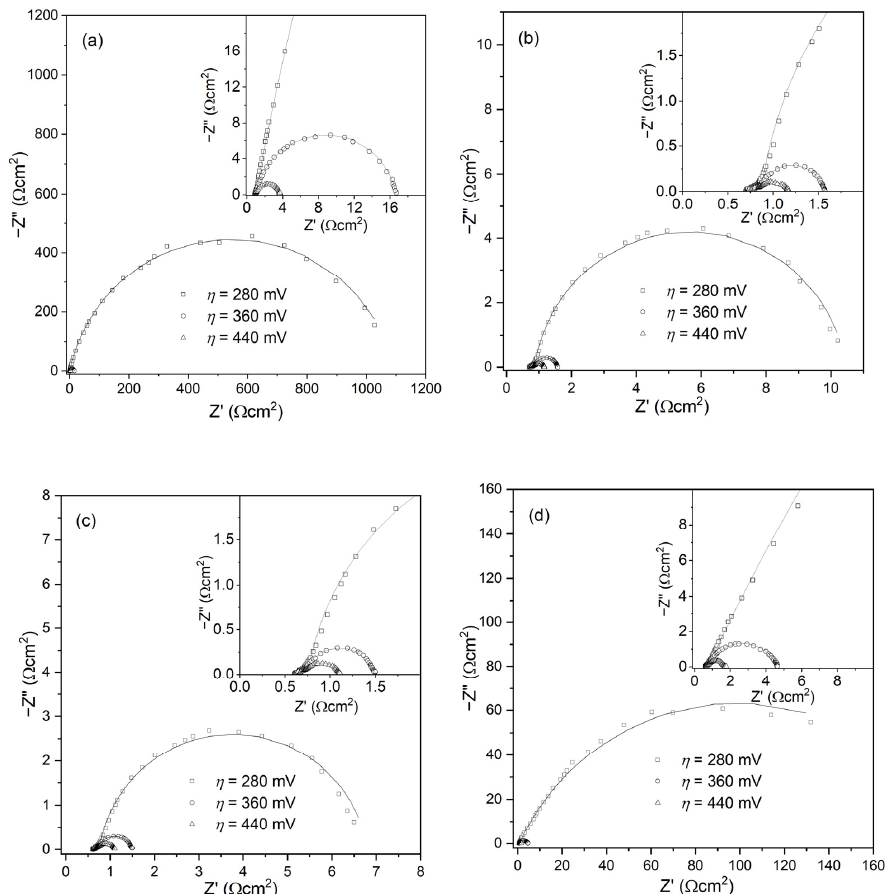
Figure 5. Complex impedance plots obtained for ( a ) Ni, ( b ) CFO PEG , ( c ) CFO Ni and ( d ) CFO Nia-r elec- trodes during the oxygen evolution process in 1 M KOH; symbols are experimental data, and lines were modelled using the electrical equivalent circuit shown in Figure 6.